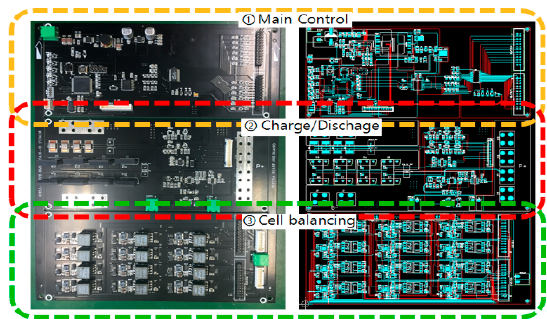
Figure 14. Mainboard and description of each part.